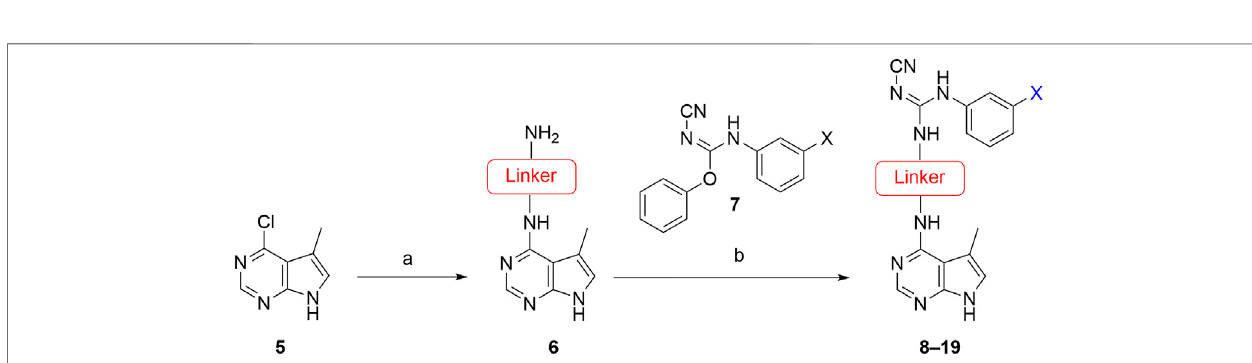
SCHEME 1 | General synthetic procedure. Reagents and condition: (A) diaminoalkane linker, diisopropylethylamine, isopropanol, re fl ux, 16 h, 50 – 97%; (B) cyanoguanidine 7 , triethylamine, MeCN, re fl ux, 16 h, 16% – 39%.